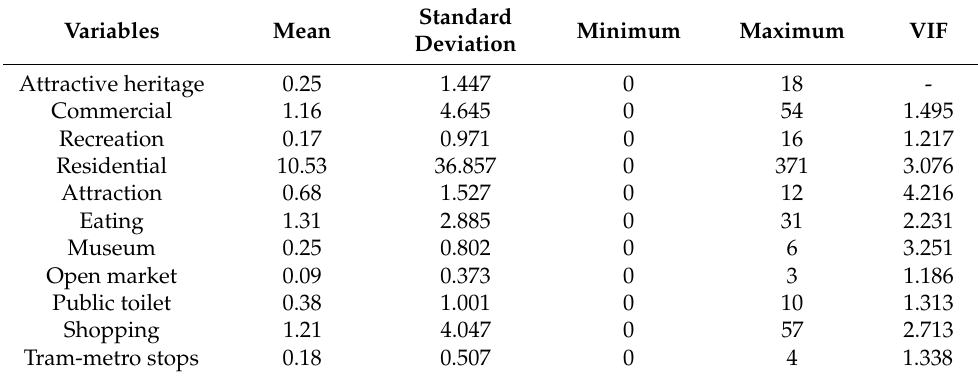
Table 3. Descriptive statistics of the data.